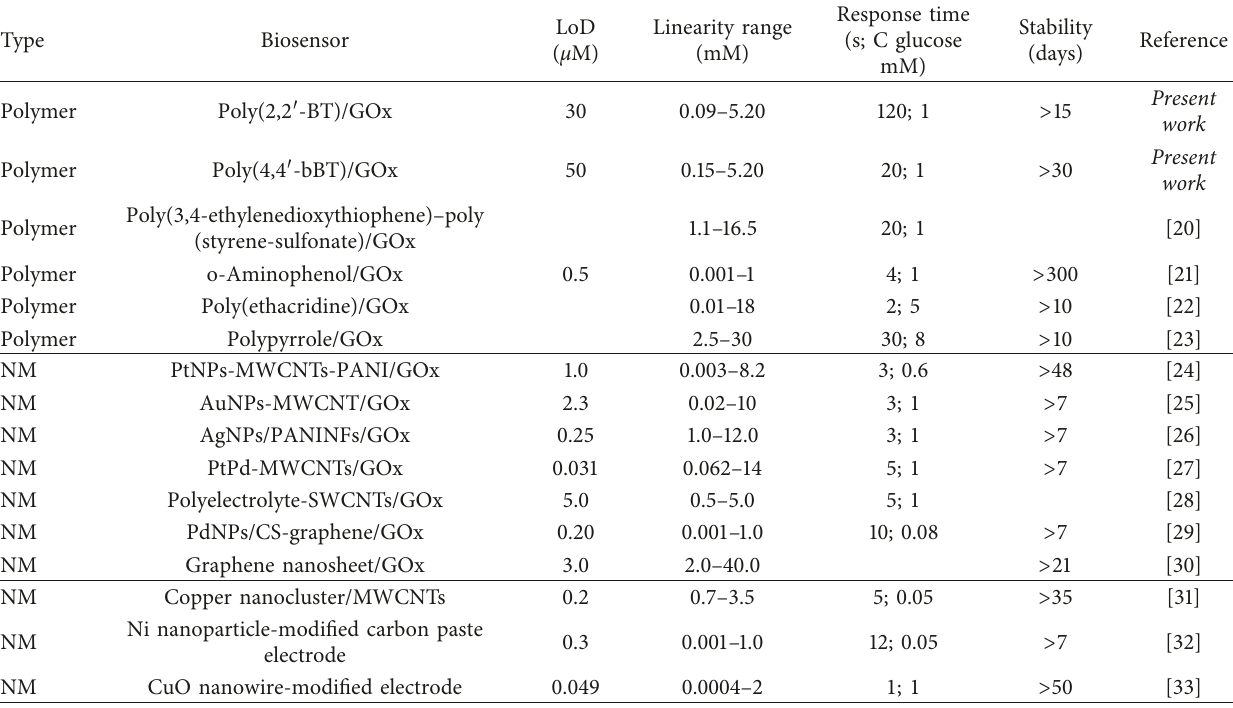
Table 2: Comparison of the performances of biosensors proposed in the present work with literature data.